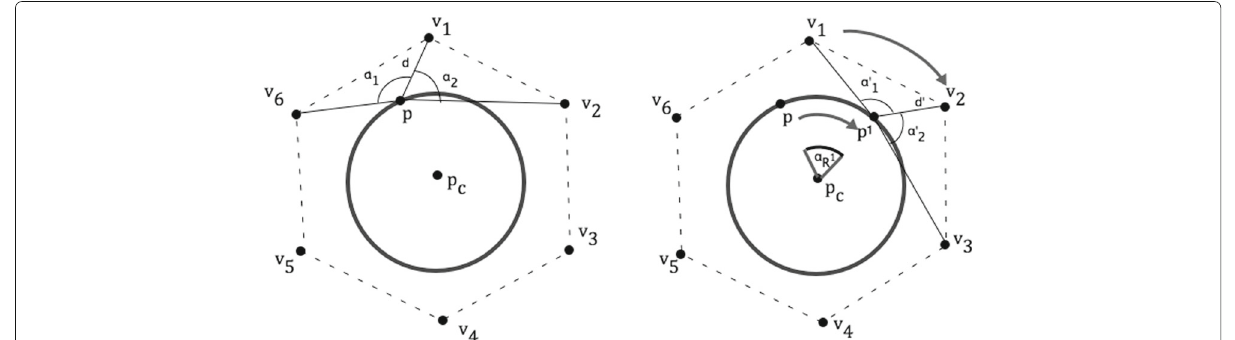
Fig. 3 Proposition 1. Illustration of the existence of a point p 1 needed to prove the second implication in Proposition 1